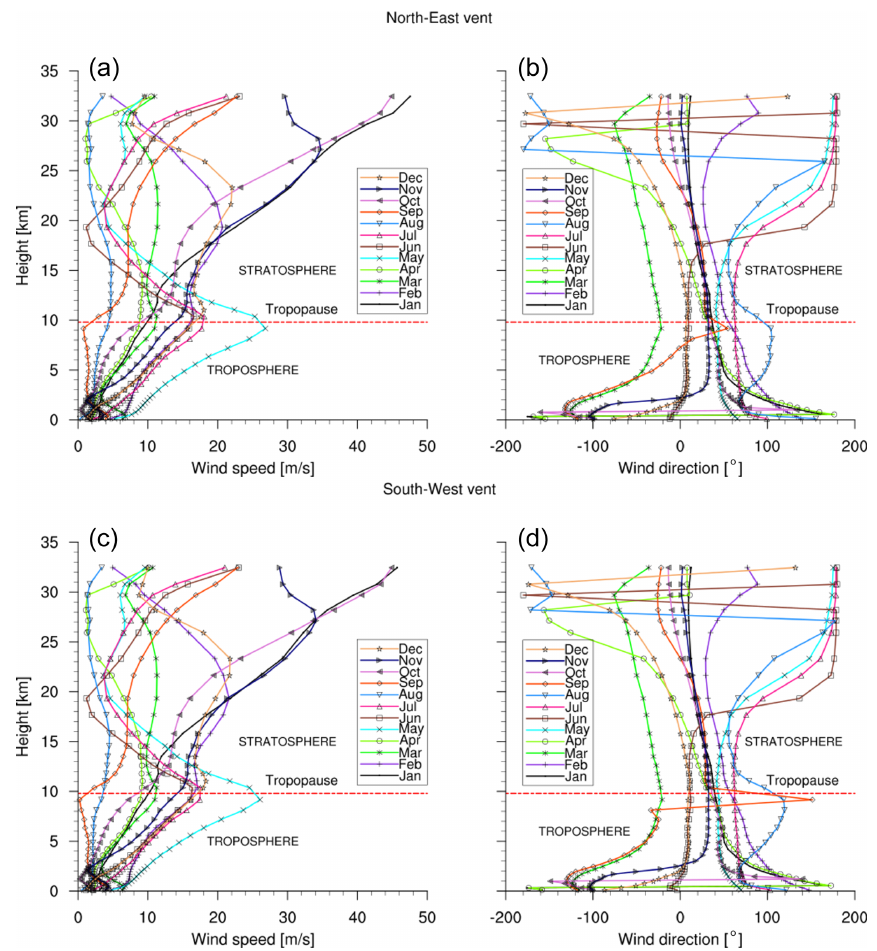
Figure 6. Monthly comparison of the wind pattern computed in two different locations (NE and SW) for a whole year, 2018. (a, b) Wind patterns corresponding to the NE vent. (c, d) Wind patterns corresponding to the SW vent. Results were obtained by averaging 1 year of ERA5